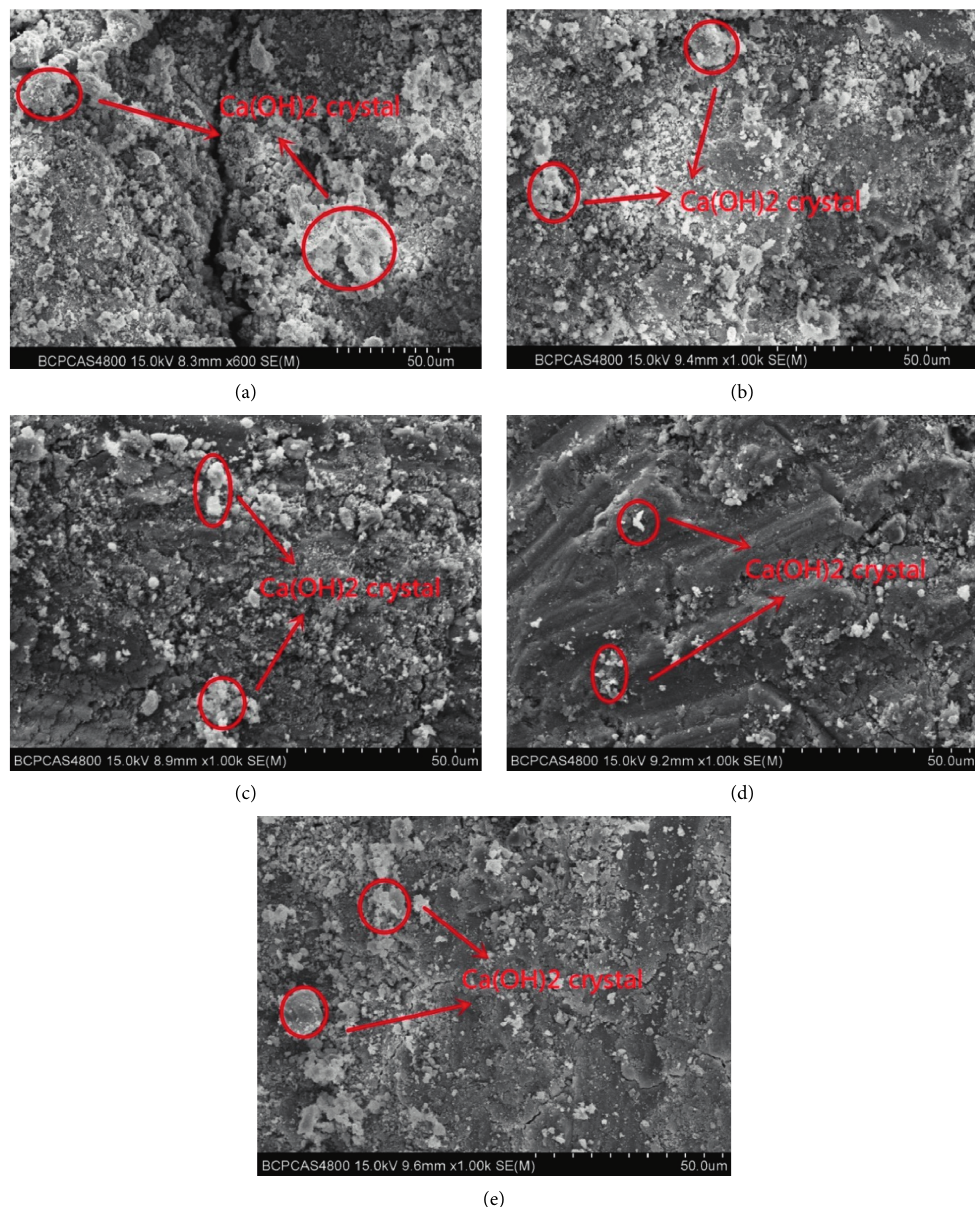
Figure 8: SEM images of cement mortar specimens with different blending proportions: (a) no additive, (b) 1.0% water-reducing agent, (c) 0.5%NS+1.0% water-reducing agent, (d) 1.0%NS +1.0% water-reducing agent, and (e) 1.5%NS+1.0% water-reducing